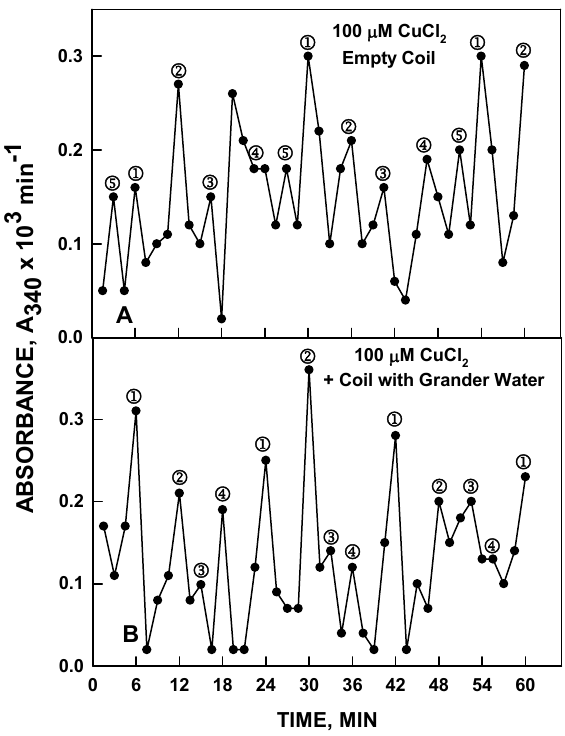
Figure 12. NADH, 120 µM, was prepared in water or 100 µM CuCl 2 with a standard copper coil filled with Grander water. The pattern shown in ( A ) was observed. The empty coil had no effect. With the coil containing Grander water, the result was the 4-peak pattern with the 18 min period of water shown in ( B ) and not the 5 peak pattern with a 24 in period characteristic of 100 µM CuCl 2 shown in A. Results with HPLC water in the coil were